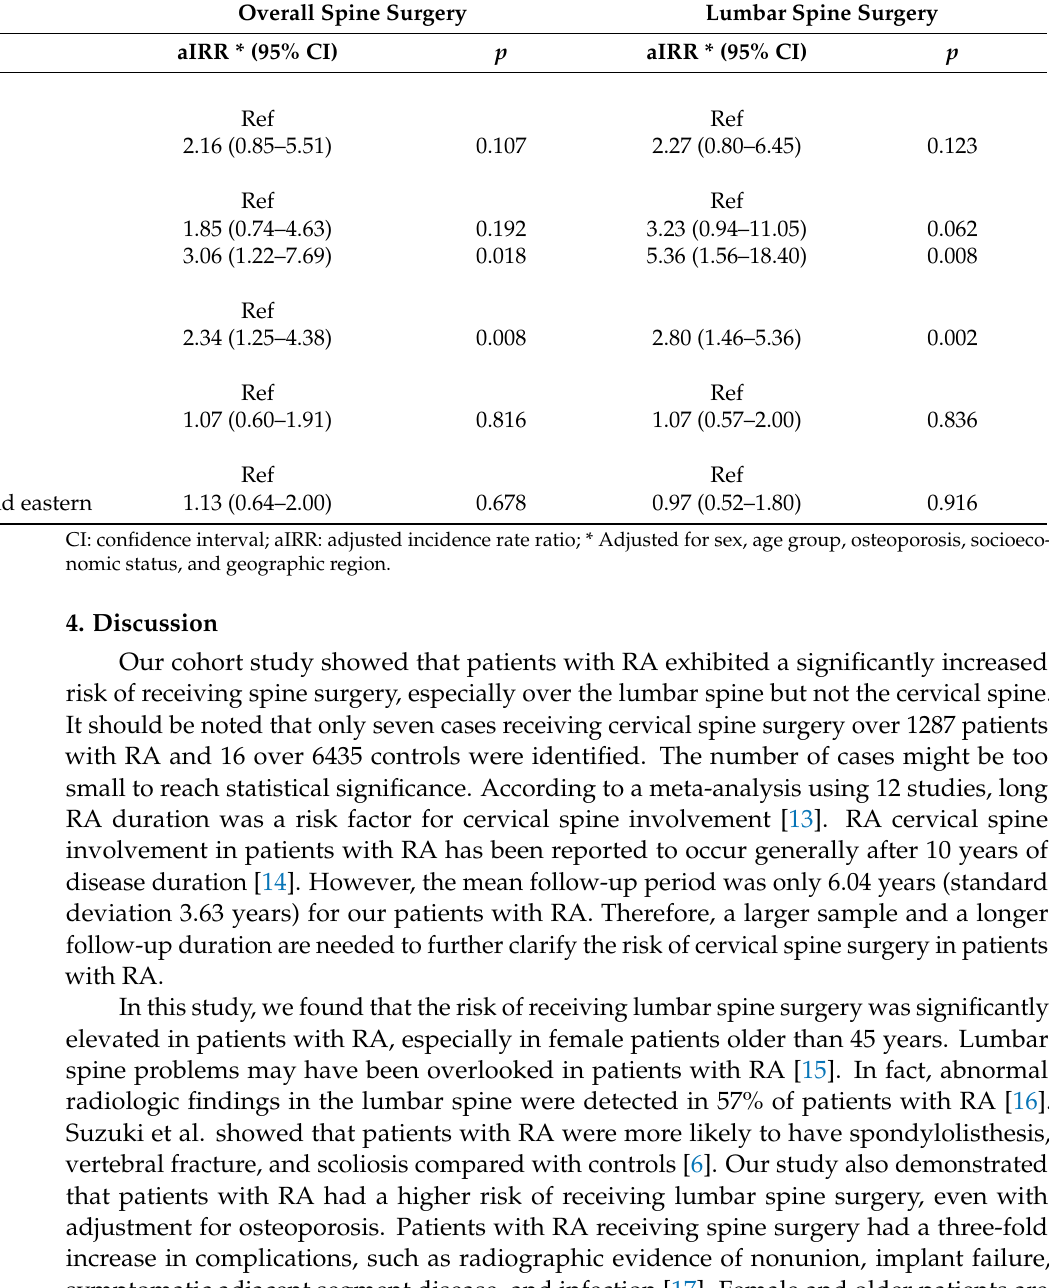
Table 4. The risk factors for spine surgery and lumbar spine surgery in the RA cohort ( n = 1287). Overall Spine Surgery Lumbar Spine